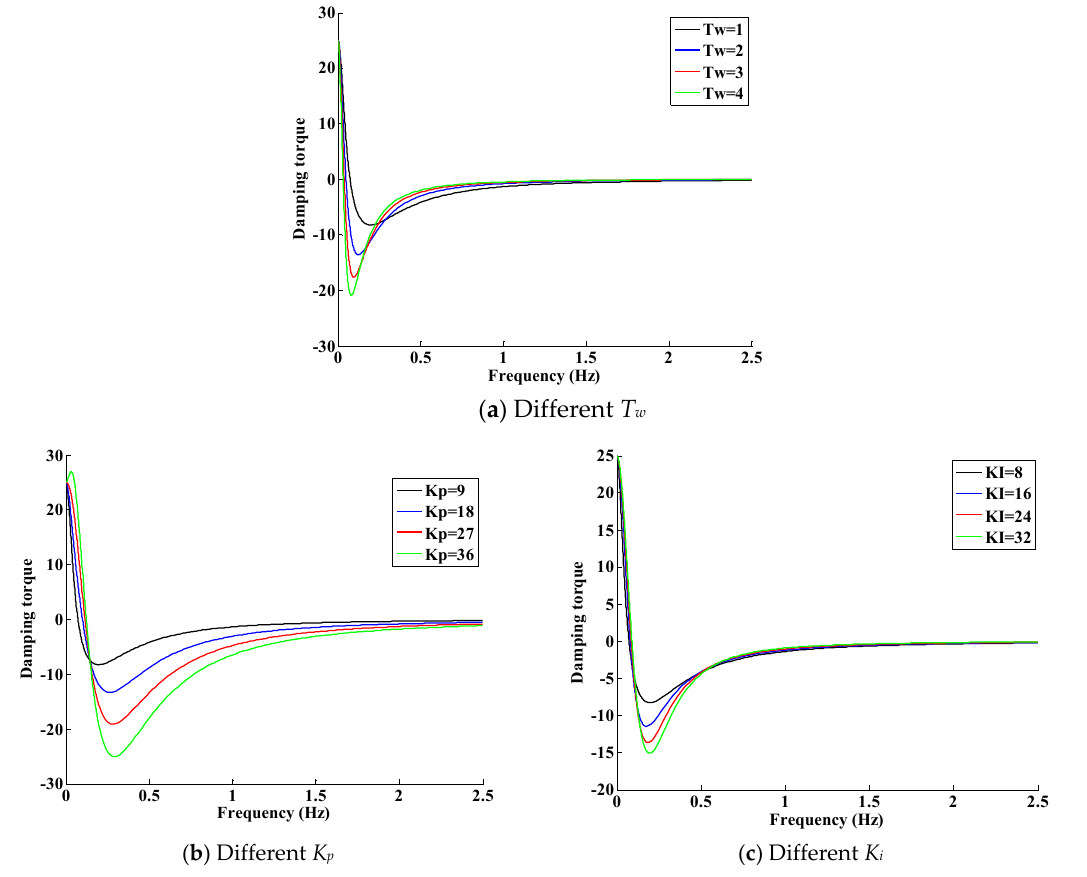
Figure 3. The damping characteristics of the governor and the turbine in a frequency range of 0–2.5 Hz.